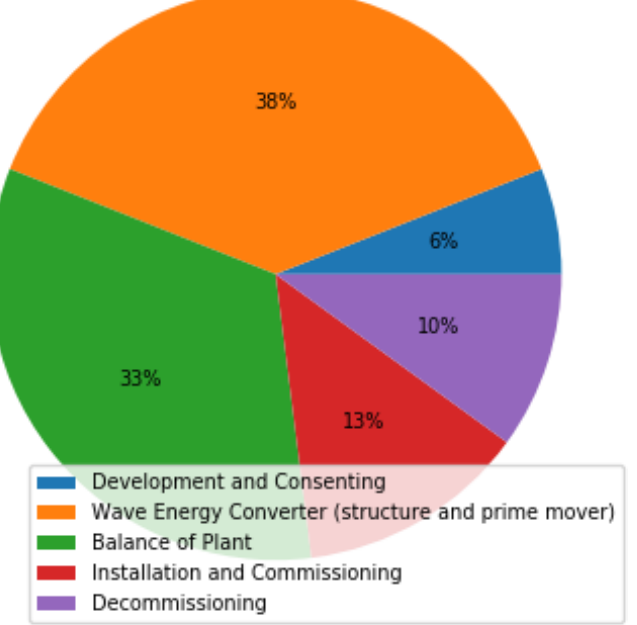
Figure 1. CAPEX breakdown of costs for the different cost